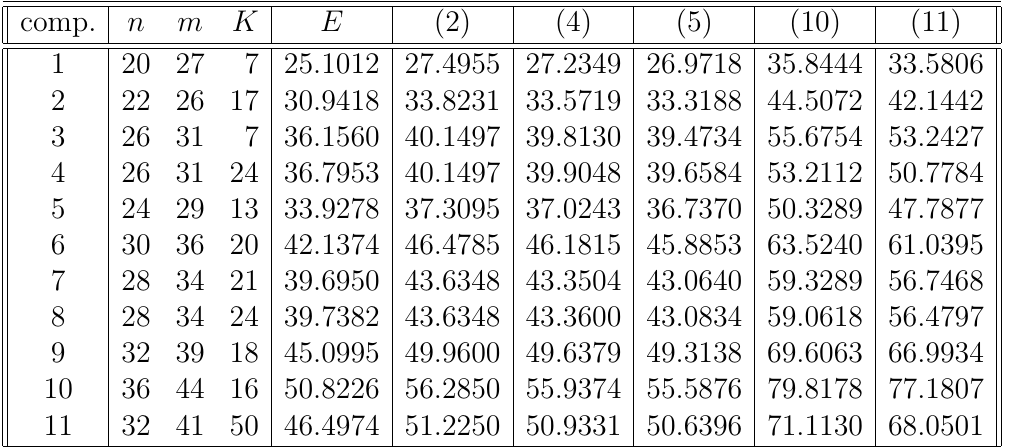
Table 2. Examples illustrating the quality of the upper bounds (2), (4), (5), (10), (11); 1 = benz[ a ]anthracene, 2 = dibenz[ a,c ]anthracene, 3 = hexacene, 4 = dibenzo[ g,p ]- chrysene, 5 = dibenzo[ b,def ]chrysene, 6 = dibenzo[ a,l ]pentacene, 7 = dibenzo[ a,e ]- perylene, 8 = naphtho[ 1,2,3,4-rst ]pentaphene, 9 = naphtho[ 8,1,2-cde ]hexacene, 10 = tetrabenzo[ a,de,l,op ]pentacene, 11 = ovalene.